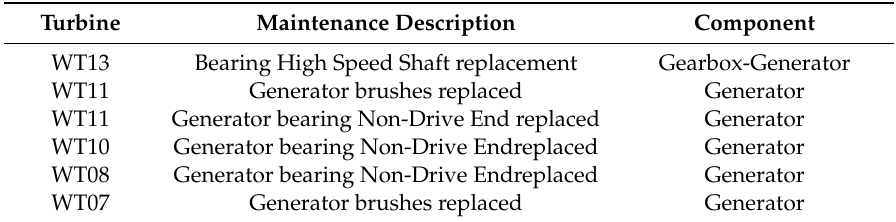
Figure 4. Comparison of the results obtained by the three implemented algorithms hybridized with alarms information. The higher the distance from the origin, the worse the conditions of the generator. Three areas are identified according to the health status: healthy (green), warning (yellow) and danger (red). The shape determines the presence and type of fault occurred. Table 8. Principal maintenance intervention occurred during the testing phase.